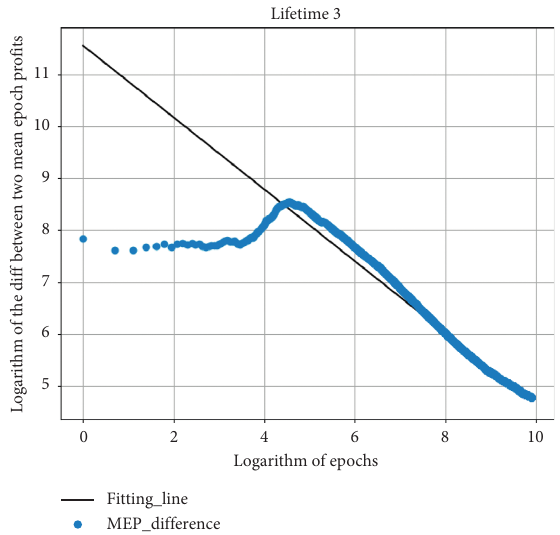
Figure 10: Log-log scale MEP difference for lifetime